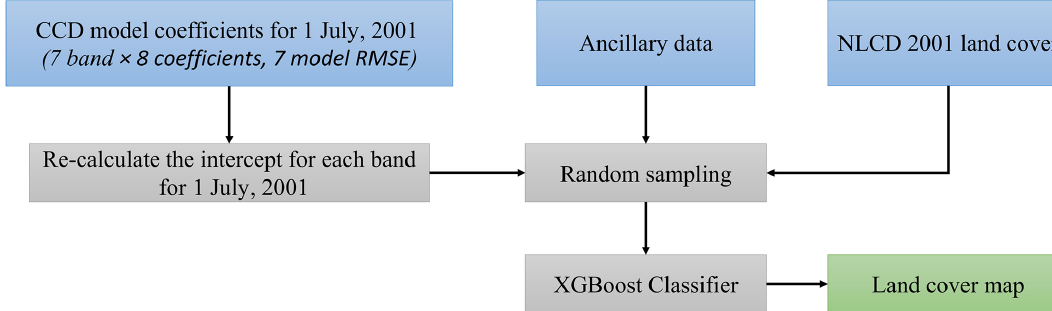
Figure 3. The overall approach of land cover classification in